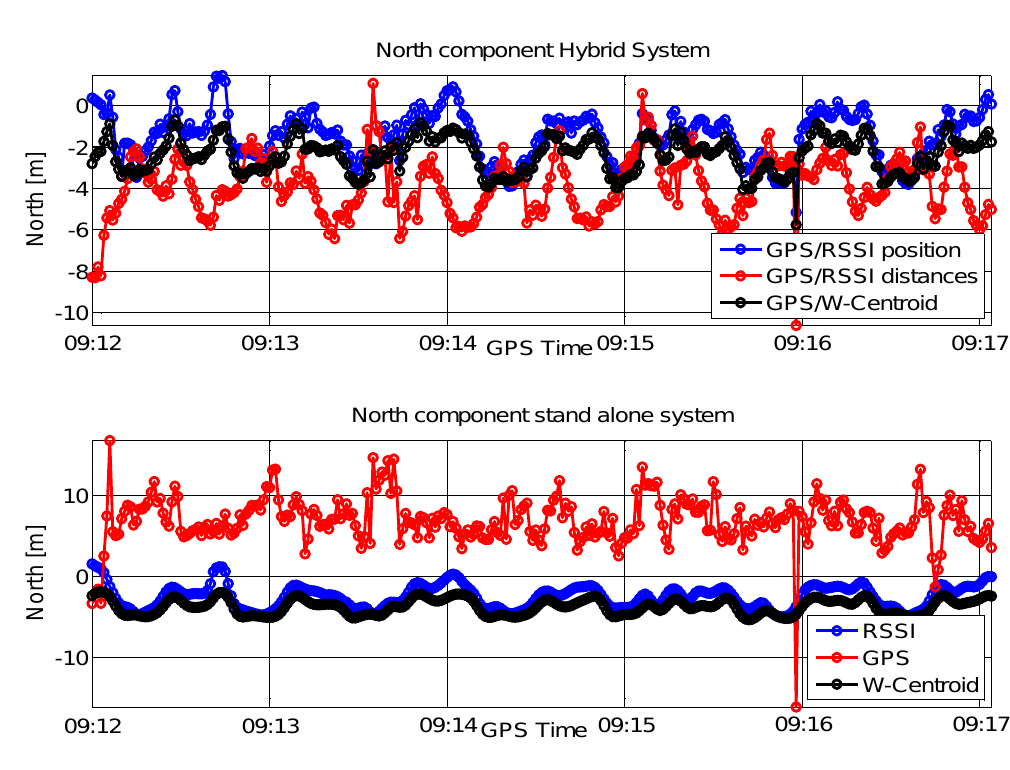
Figure 11. North component estimated for the repeatability test performed in a large meeting